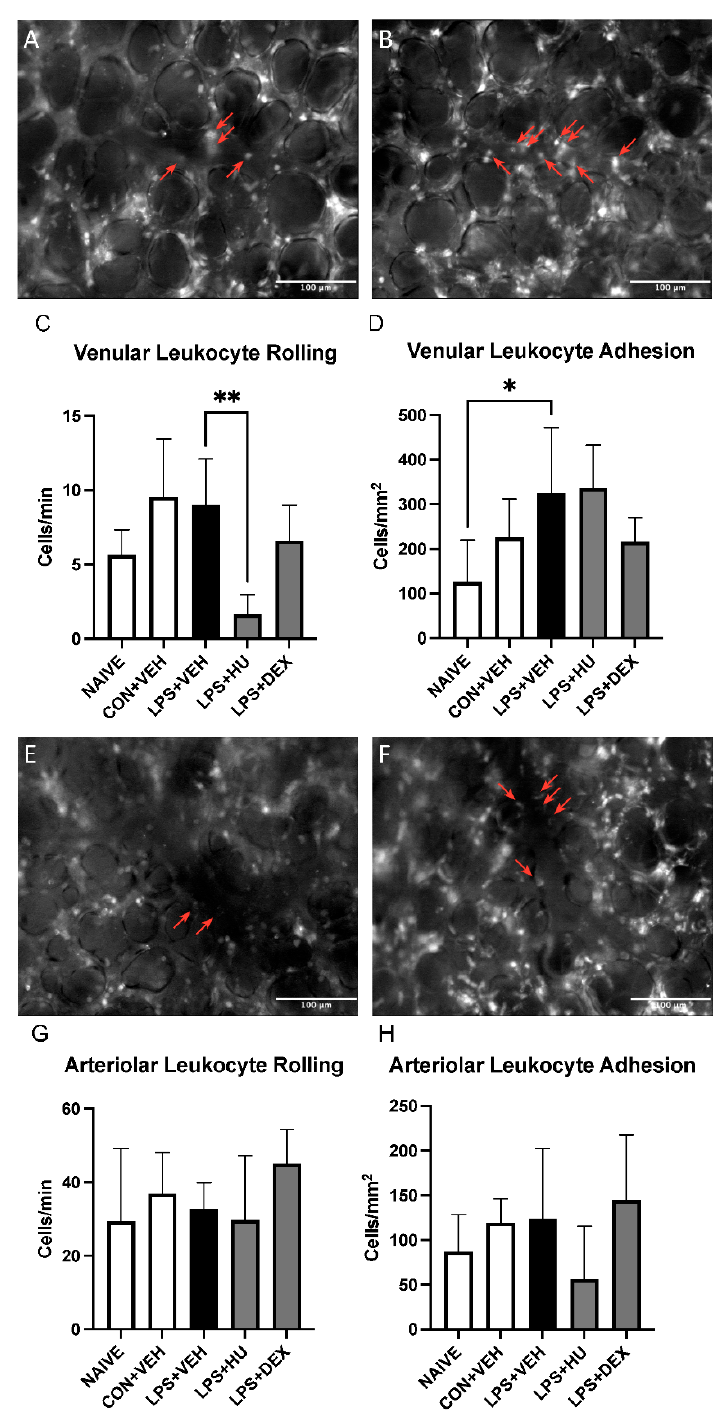
Figure 7. Impact of LPS and treatment on leukocyte activation in pulmonary venules and arterioles. Representative images of pulmonary venules in ( A ) con + veh mice and ( B ) LPS + veh mice. Analysis of leukocyte ( C ) rolling and ( D ) adhesion in pulmonary venules. Representative images of pulmonary arterioles in ( E ) con + veh mice and ( F ) LPS + veh mice. Analysis of leukocyte ( G ) rolling and ( H ) adhesion in pulmonary arterioles. Red arrows denote adherent leukocytes. Data are expressed as mean ± SD. Statistically significant differences were determined via one-way ANOVA with Dunnett’s multiple comparisons test and are depicted as * p ≤ 0.05, ** p ≤ 0.01.